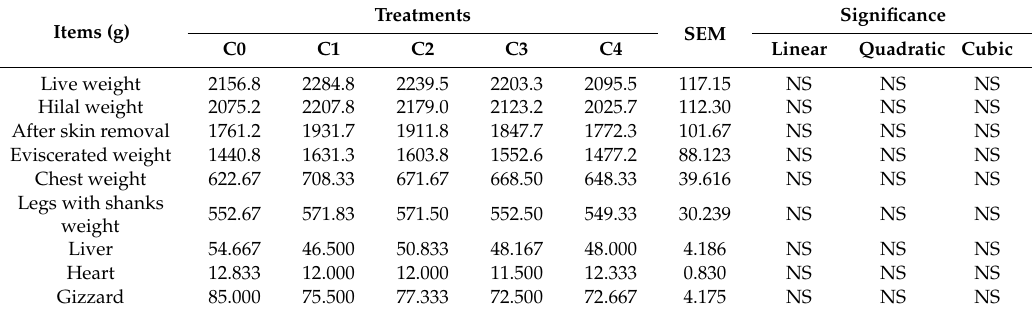
Table 5. E ff ect of chromium propionate on carcass